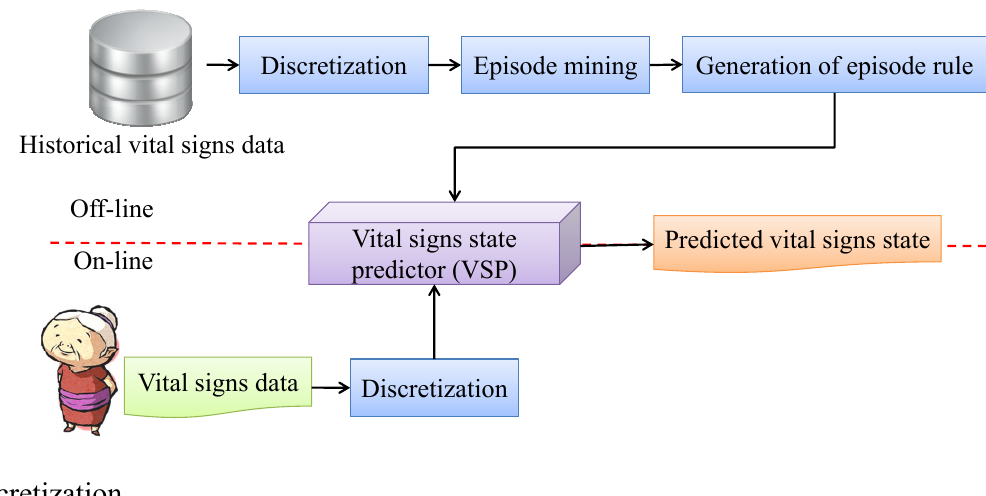
Figure 3. Flowchart of vital signs state predictor